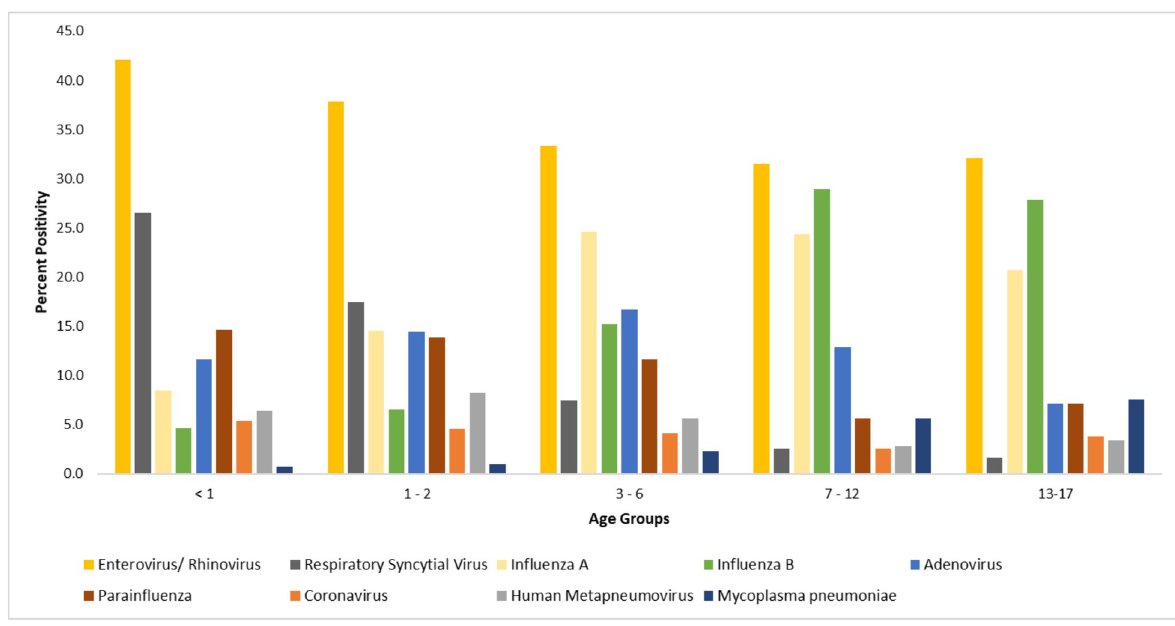
Fig 1. The percentage positivity of respiratory pathogens detected in different paediatric age groups.